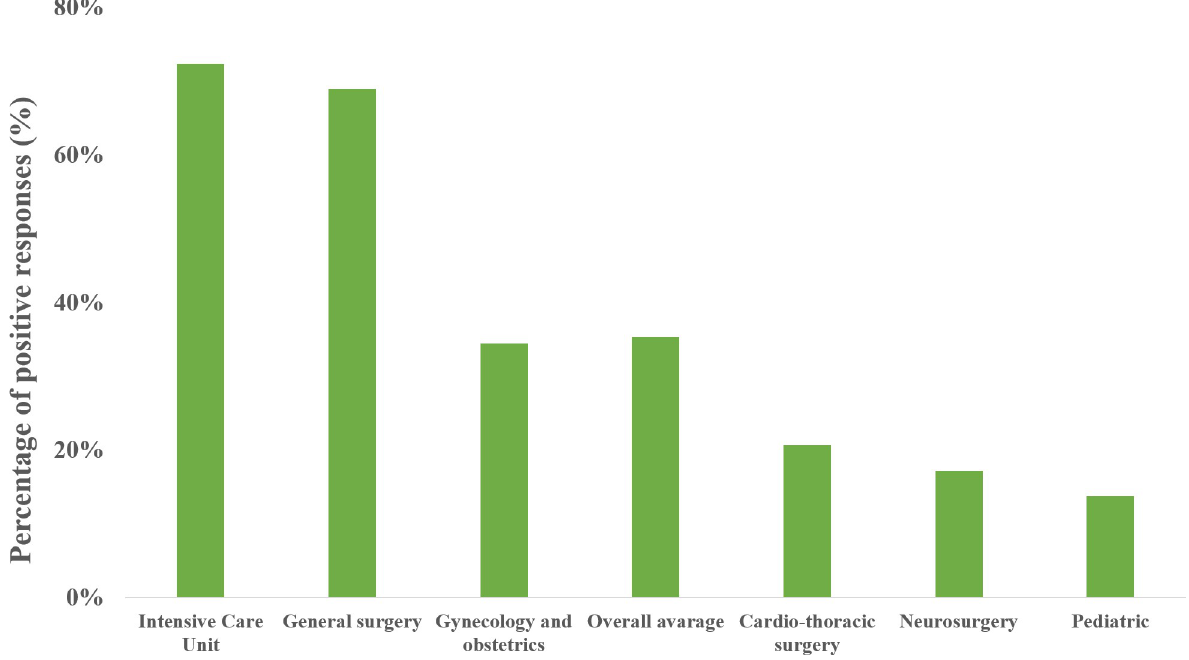
Fig 2. Immediate availability regarding clinical areas. The most and the least supplied clinical areas with immediate availability of VL in Croatia according to this survey (n = 29) and based on positive answers given to the following question: “At which workstation at your workplace do you have a VL immediately/readily available? (Option for multiple